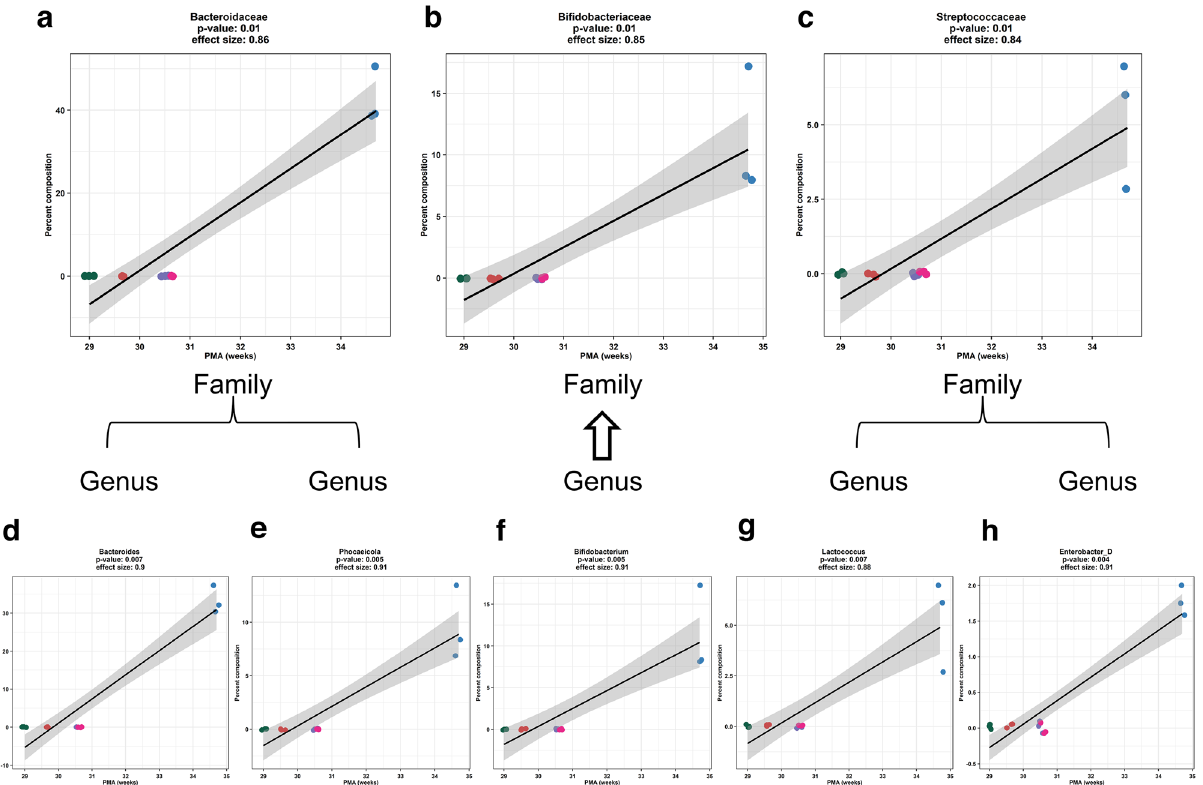
Figure 3. Distinct bacterial family and genus abundance in 4 weeks old fecal samples. For the 4 weeks old samples, the relative abundance (OTUs) of three families ( Bacteroidaceae , Bifidobacteriaceae , and Streptococcaceae ) increased with PMA ( a – c ). Five genera ( Bacteroides, Phocaeicola, Bifidobacterium, Lactococcus, Enterobacter_D ) were positively enhanced with PMA ( d – i ). All reached significance at p < 0.05 by Pearson correlation analysis.